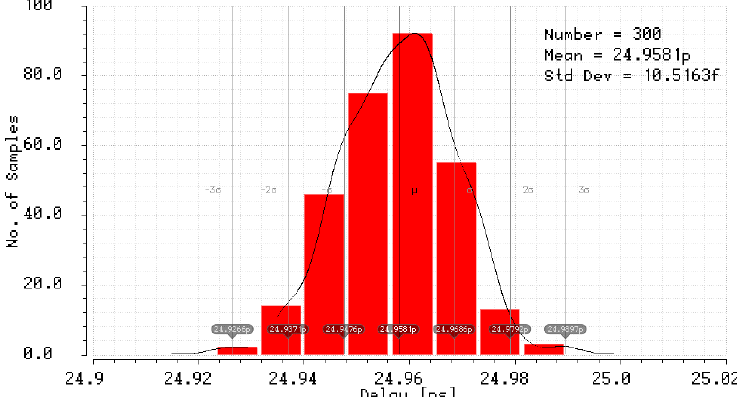
Figure 39. Simulation results of delay jitter for unit delay element (pair of inverters) for 180 nm CMOS process.